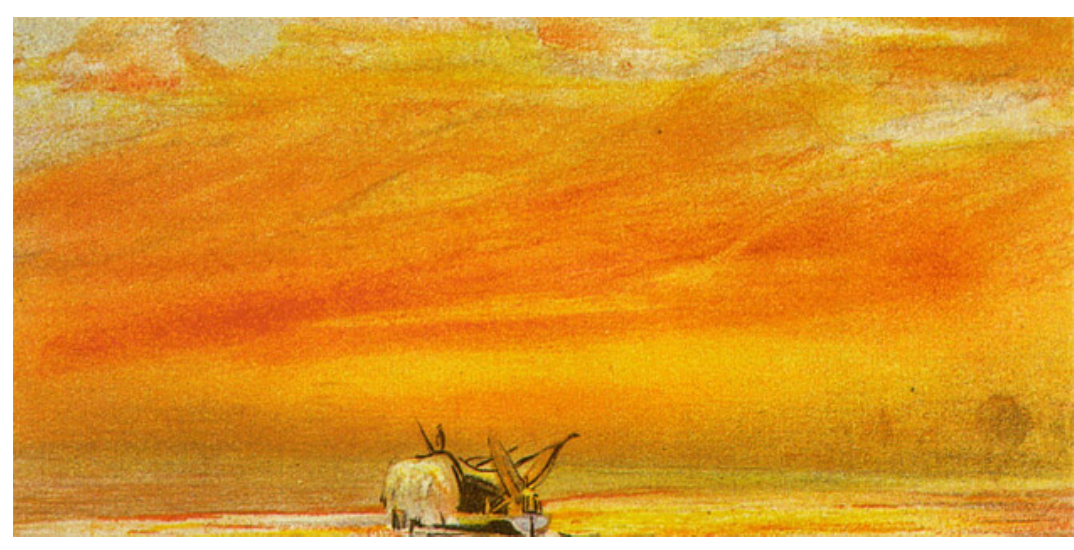
Figure 2. Sunset by British artist William Ashcroft depicting the colorful skies after the eruption of Krakatoa in 1883. Reproduced with permission from [24], Copyright © 2012 Photo Researchers,